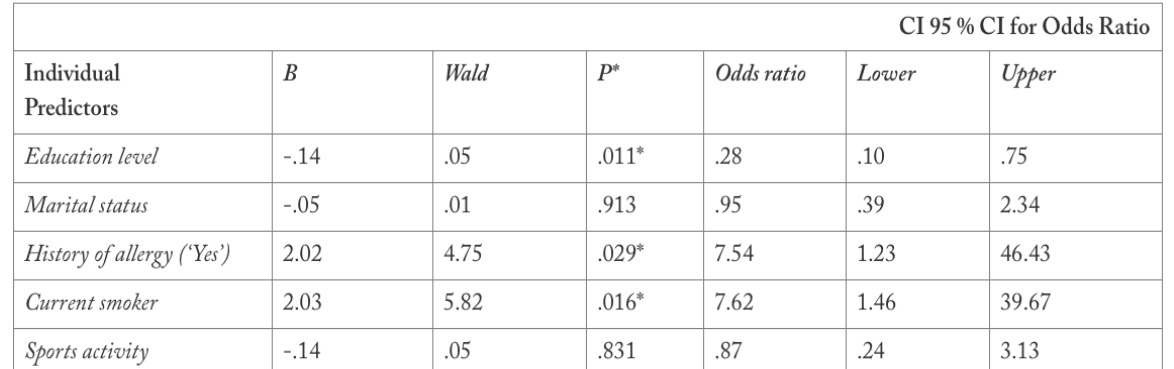
Table 6 . Results of the logistic regression analysis with individual parameters predicting SBS cases among COs ( n